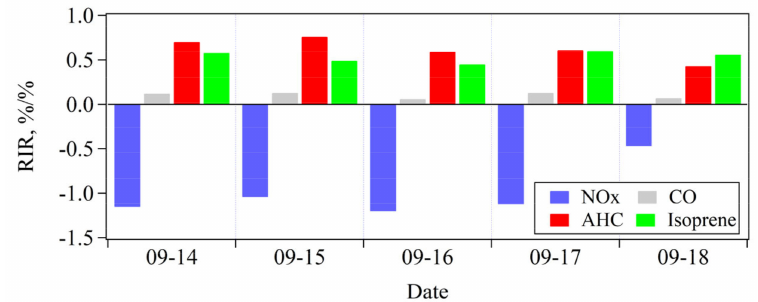
Figure 11. Daily Relative incremental reactivity (RIR) values for NO X , CO, isoprene, and anthropogenic hydrocarbons (AHC) during the O 3 pollution